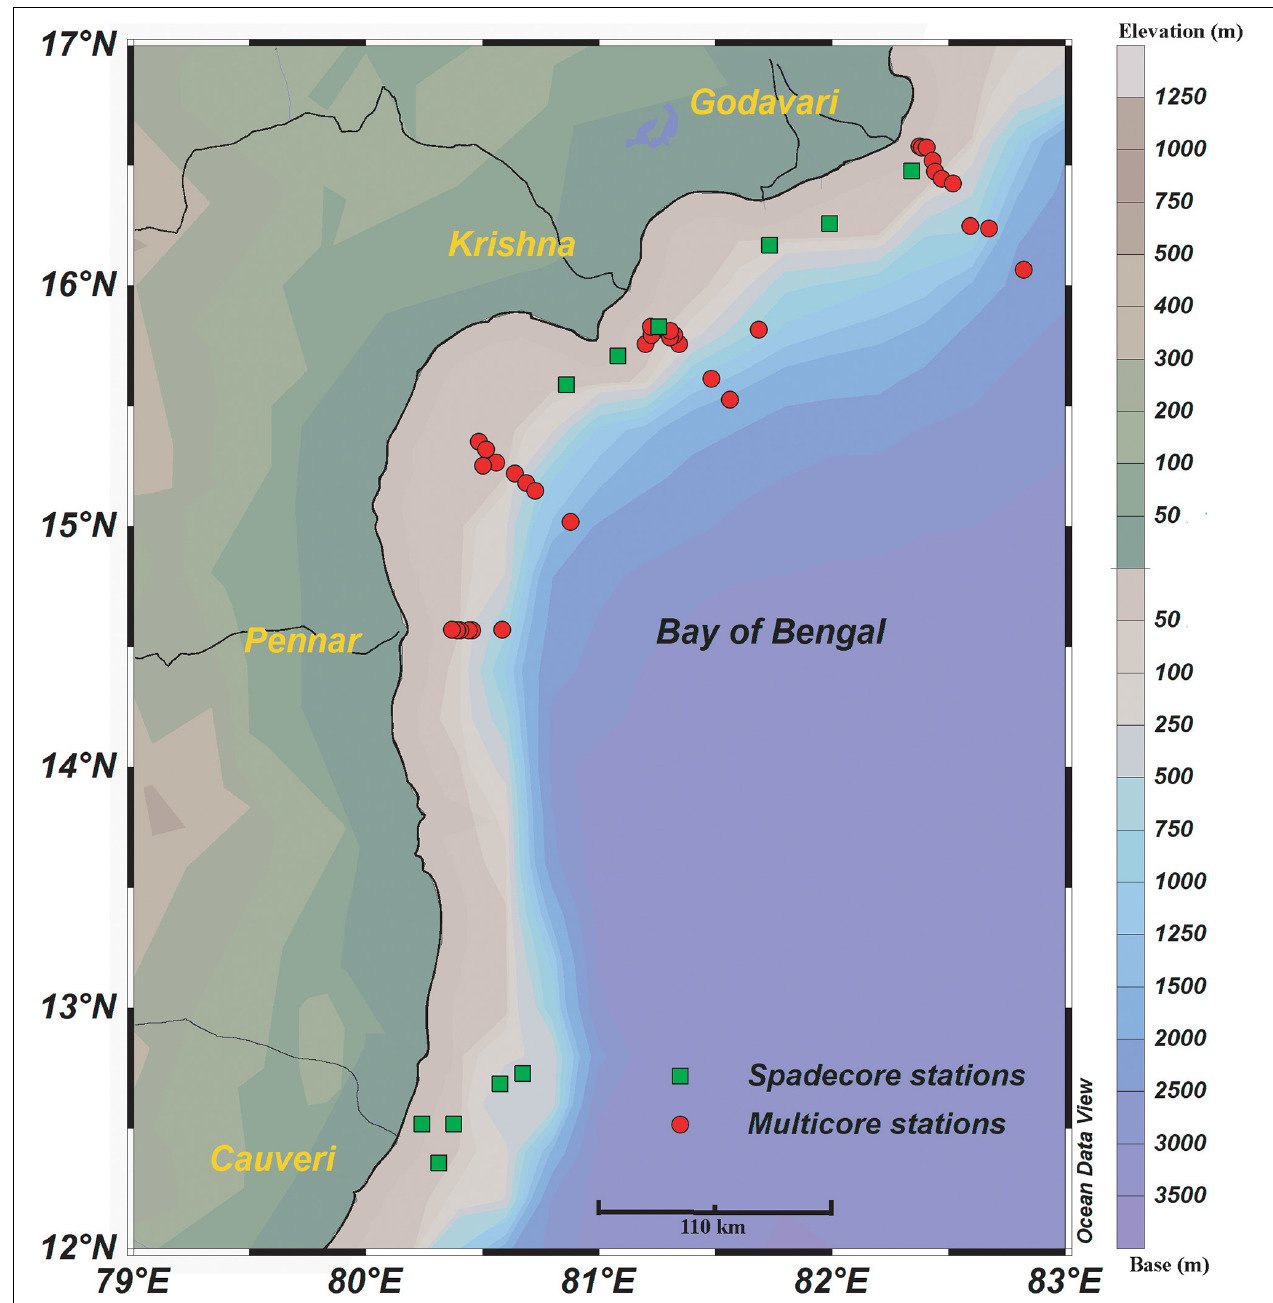
FIGURE 1 | The location of surface sediment samples in the west-central Bay of Bengal. Multicore stations are marked with red circles and green squares represent spade core stations. The major rivers draining in the area are marked by thin black lines. The bathymetry is marked by colored